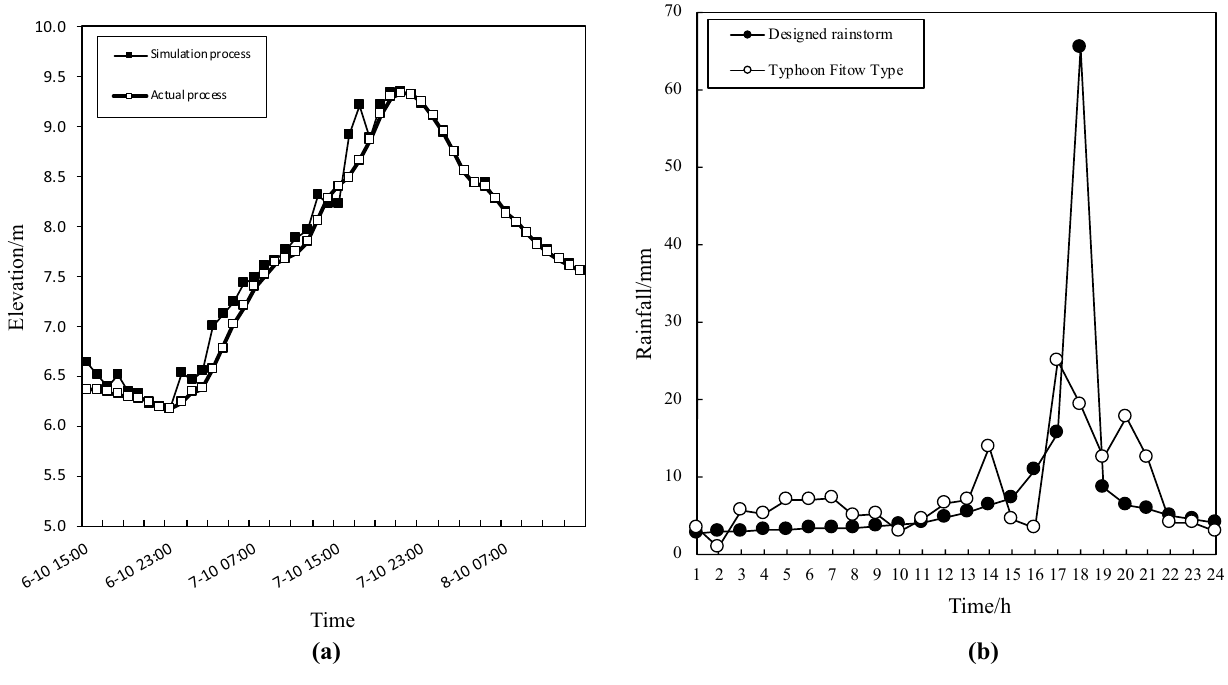
Fig. 2 a Evaluation of Shiliqu hydrodynamic model and b comparison of the designed rainstorm and the typhoon Fitow rain pattern